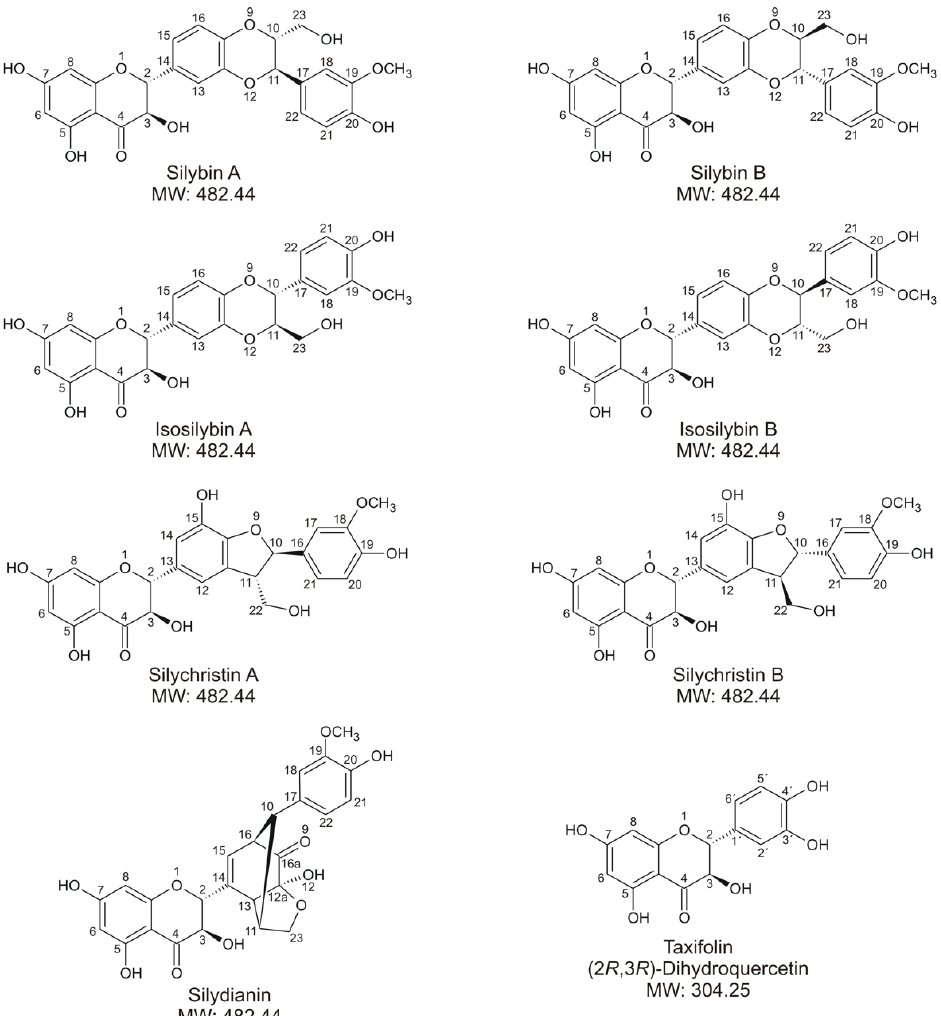
Figure 1. Chemical structures of tested silymarin constituents.